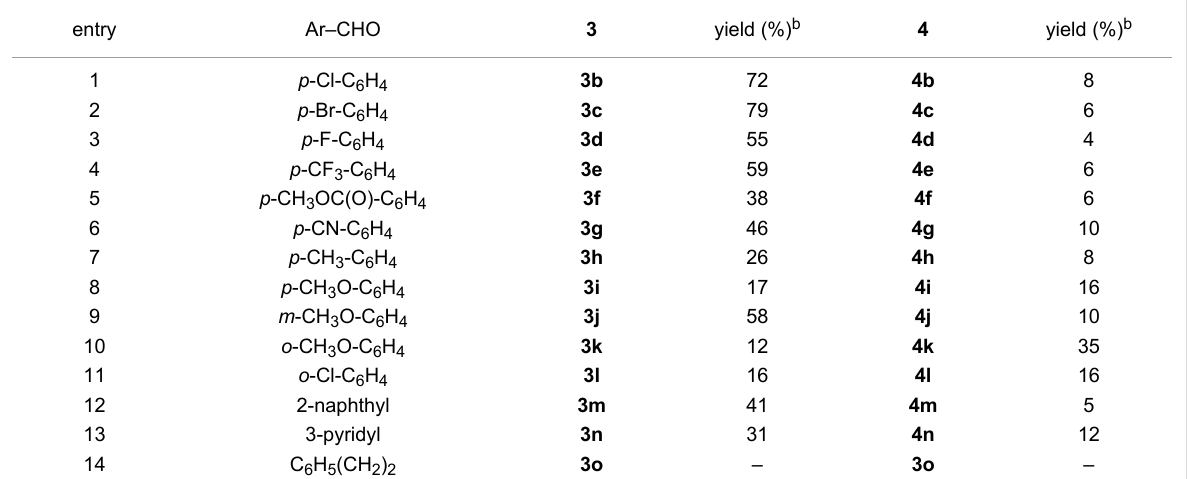
Table 2: Investigation of reaction scope with optimal conditions.